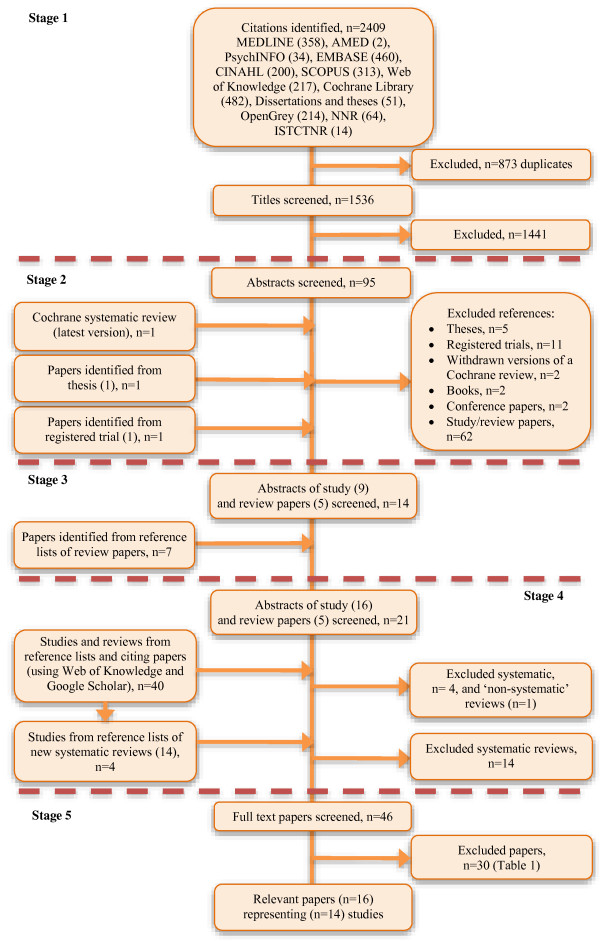
Search strategy.